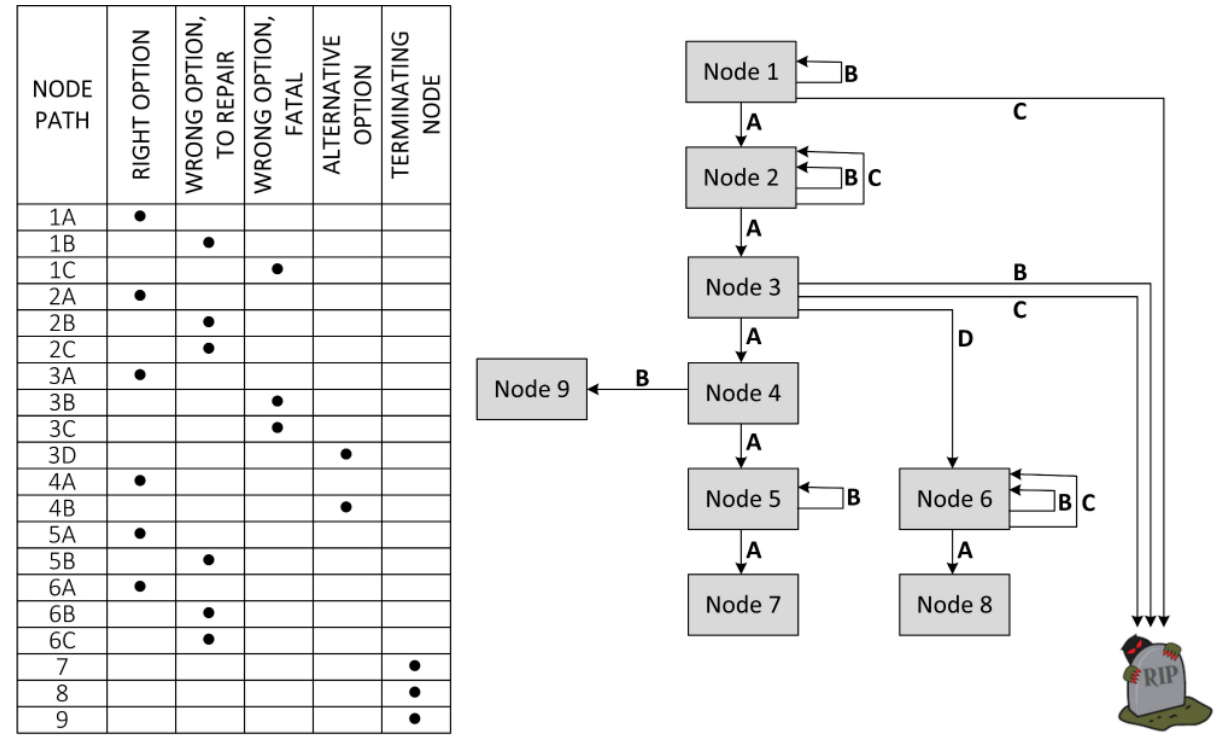
Figure 4. Various types of nodes and options/answers that may be used for authoring an interactive algorithm.